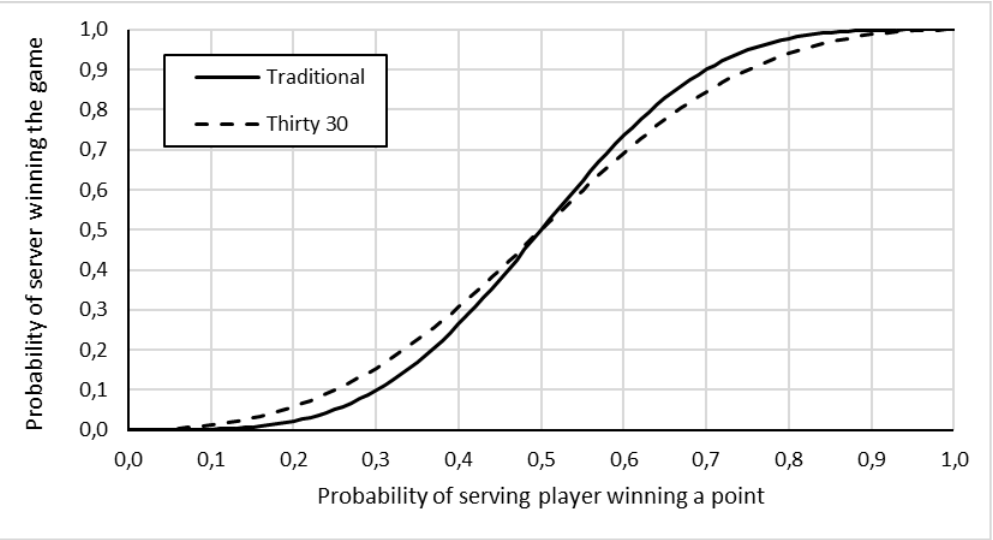
Figure 3. The probability of the serving player winning a